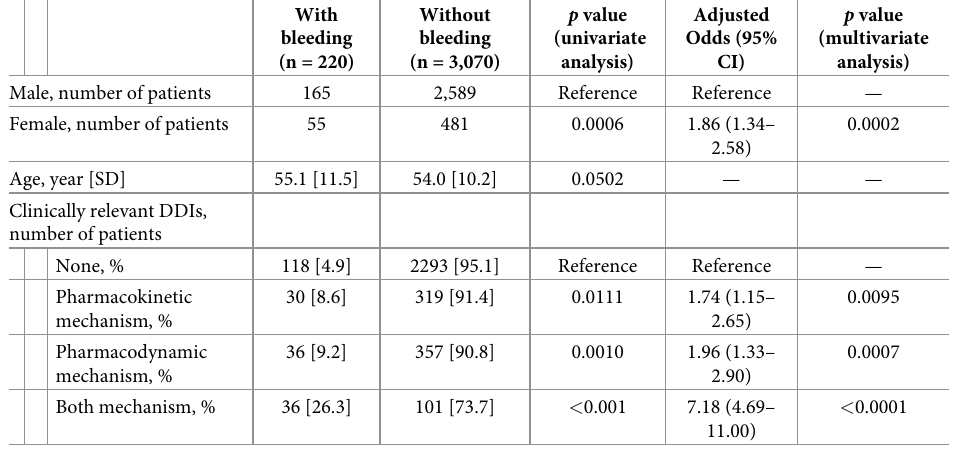
Table 3. Factors associates with bleeding after administered anti-coagulant in atrial fibrillation patients in a large claims data in Japan. With Without Adjusted p value p value bleeding bleeding (univariate Odds (95% (multivariate (n = 220) (n = 3,070) analysis) CI) analysis) Male, number of patients 165 2,589 Reference Reference — Female, number of patients 55 481 0.0006 1.86 (1.34– 0.0002 2.58) Age, year [SD] 55.1 [11.5] 54.0 [10.2] 0.0502 — — Clinically relevant DDIs, number of patients None, % 118 [4.9] 2293 [95.1] Reference Reference — Pharmacokinetic 30 [8.6] 319 [91.4] 0.0111 1.74 (1.15– 0.0095 mechanism, % 2.65) Pharmacodynamic 36 [9.2] 357 [90.8] 0.0010 1.96 (1.33– 0.0007 mechanism, % 2.90) Both mechanism, % 36 [26.3] 101 [73.7] < 0.001 7.18 (4.69– < 0.0001 11.00) Patients under poly-DDIs were duplicately counted in each DDI